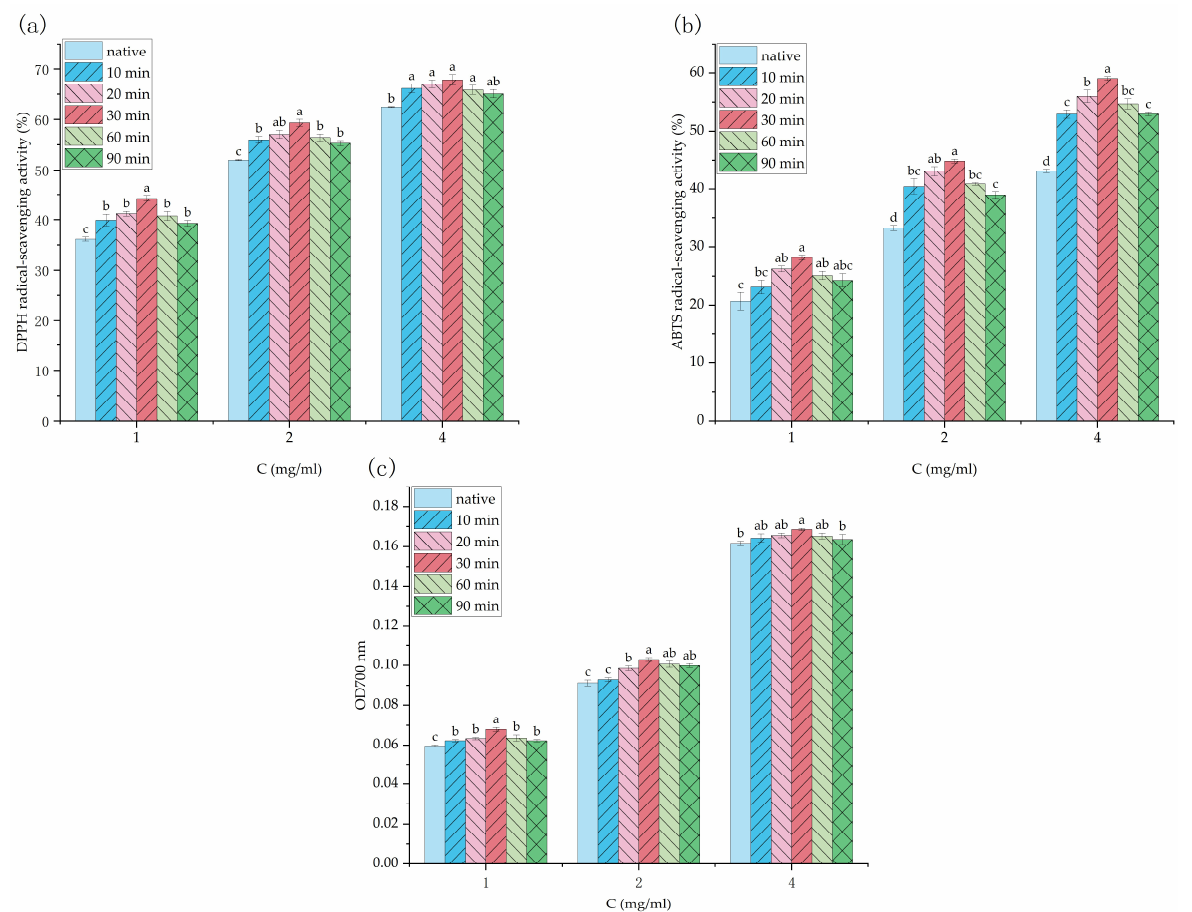
Figure 5. Antioxidant activity analysis of SBP and its ultrasonic degradation products. ( a ) DPPH radical scavenging activity, ( b ) ABTS radical scavenging activity and ( c ) reducing power. Different letters a–d indicate significant differences ( p < 0.05).